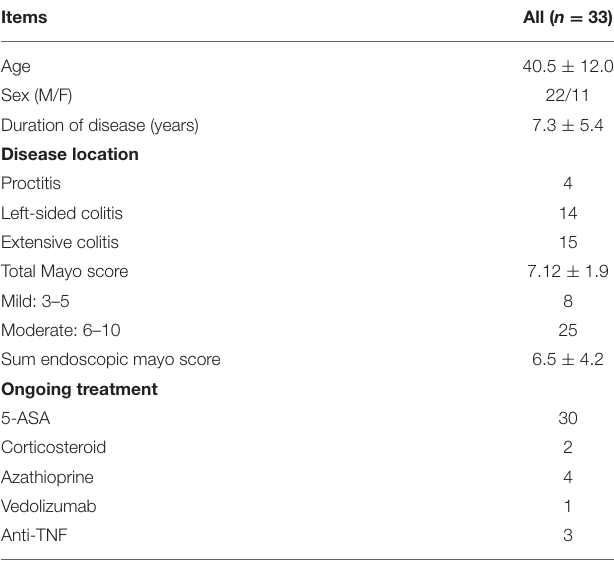
TABLE 4 | The baseline characteristics of the study